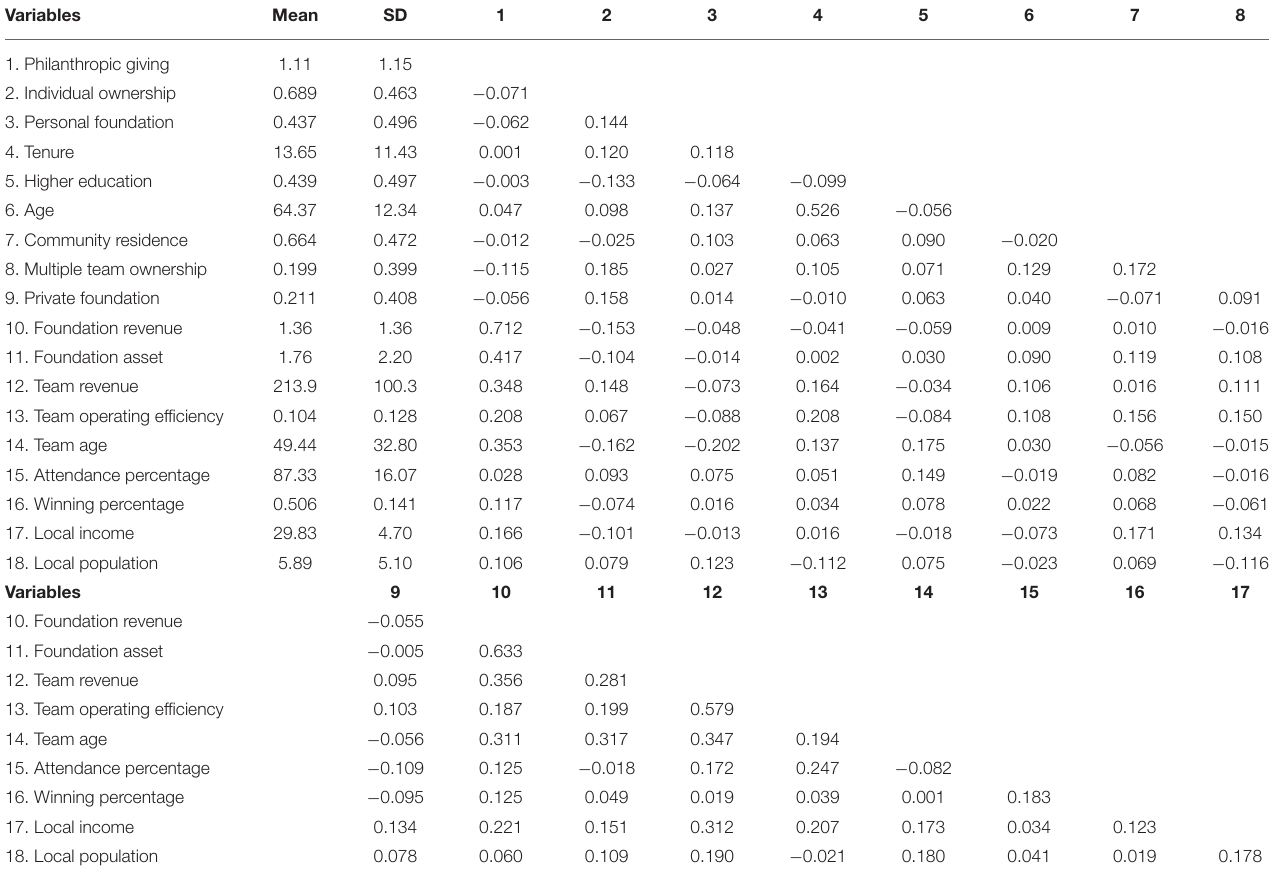
TABLE 1 | Descriptive statistics and correlations.